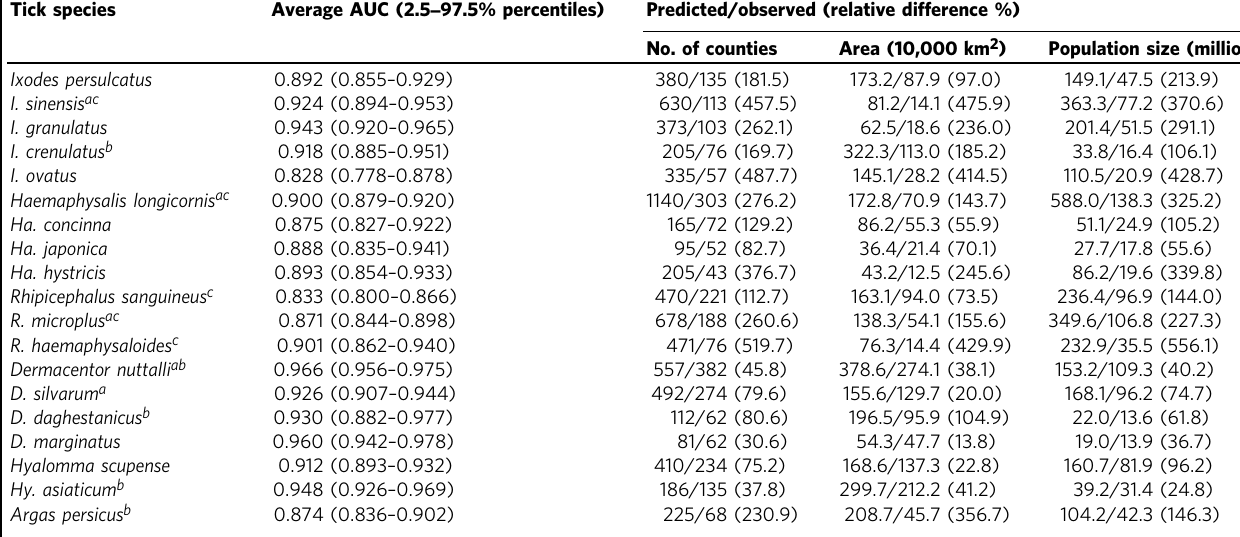
Table 1 The average testing areas under the curve (AUC) of the BRT models at the county level and model-predicted numbers, areas and population sizes of affected counties for the 19 most prevalent tick species in